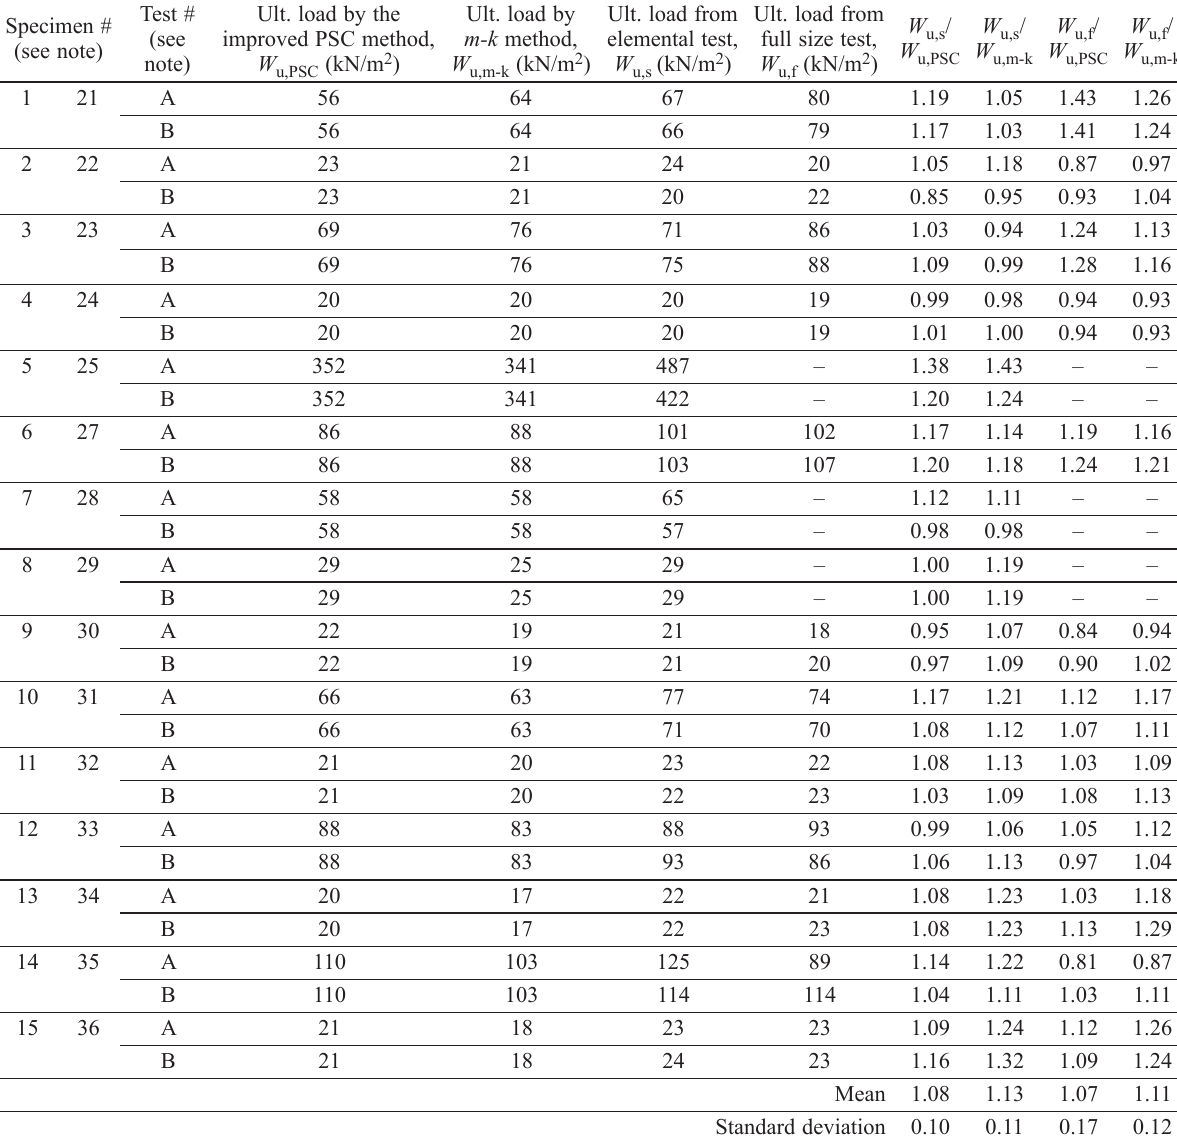
Table 5. Ultimate loads for the slabs calculated by the PSC method using Eqn (25) and the m-k method using Eqn (2) as well as their comparisons with the elemental and full size test data Specimen # (see